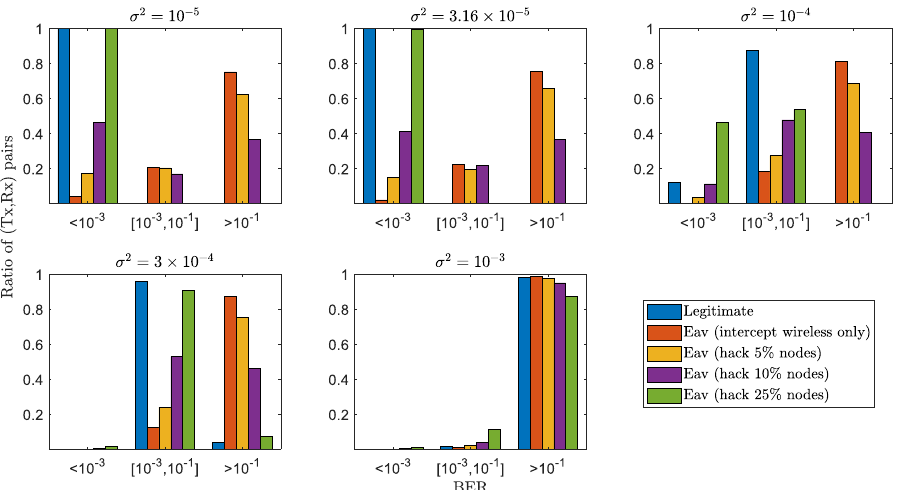
Figure 4. Statistical distribution of all (Tx,Rx) pairs with respect to different levels of BERs with passive